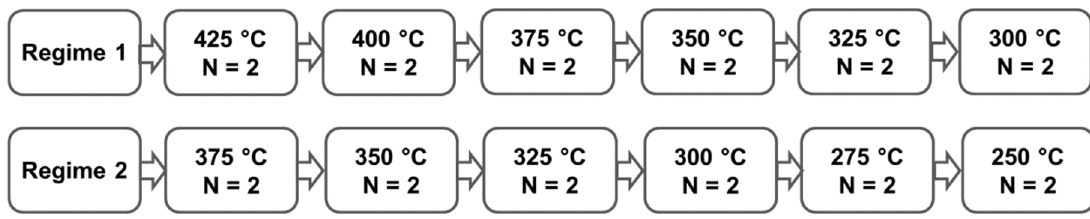
Figure 1. The equal-channel angular pressing (ECAP) processing regimes employed. (N denotes the number of passes at a given temperature.).